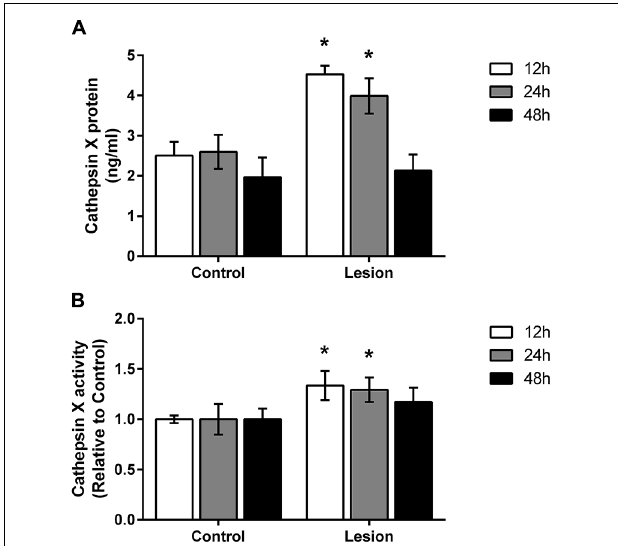
FIGURE 3 | Time-dependent increase of cathepsin X protein level and activity in the SNc following 6-OHDA injection. (A) ELISA analysis of the cathepsin X protein level in the SNc dissected from the coronal midbrain sections from the 12, 24, and 48 h time-points after 6-OHDA-induced lesion. Cathepsin X protein levels in the ipsilateral SNc (Lesion) were significantly increased at 12 and 24 h after 6-OHDA injection compared to the contralateral side (Control), whereas no changes in protein expression were detected after 48 h injection. (B) Enzyme activity analysis shows an increase in cathepsin X activity in the ipsilateral SNc (Lesion) at 12 and 24 h after 6-OHDA-induced lesion, whereas after 48 h the increase in cathepsin X activity in the ipsilateral side was not significant compared to the contralateral side (Control). Values are means ± SD of group of four animals, each analyzed in duplicate. ∗ P <